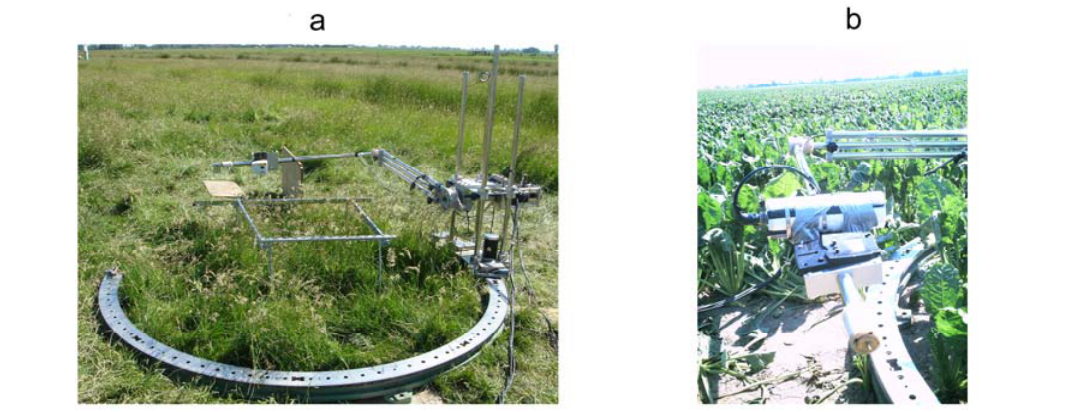
(tall) during the EAGLE2006 fieldcampaign, Cabauw (The Netherlands). The goniometer, the Irisys thermal camera and the Everest radiometer are shown. (b) Shows the goniometer in the sugar beet field during the AGRISAR2006 fieldcampaign, Demmin (Germany). The CIMEL312-1 radiometer is